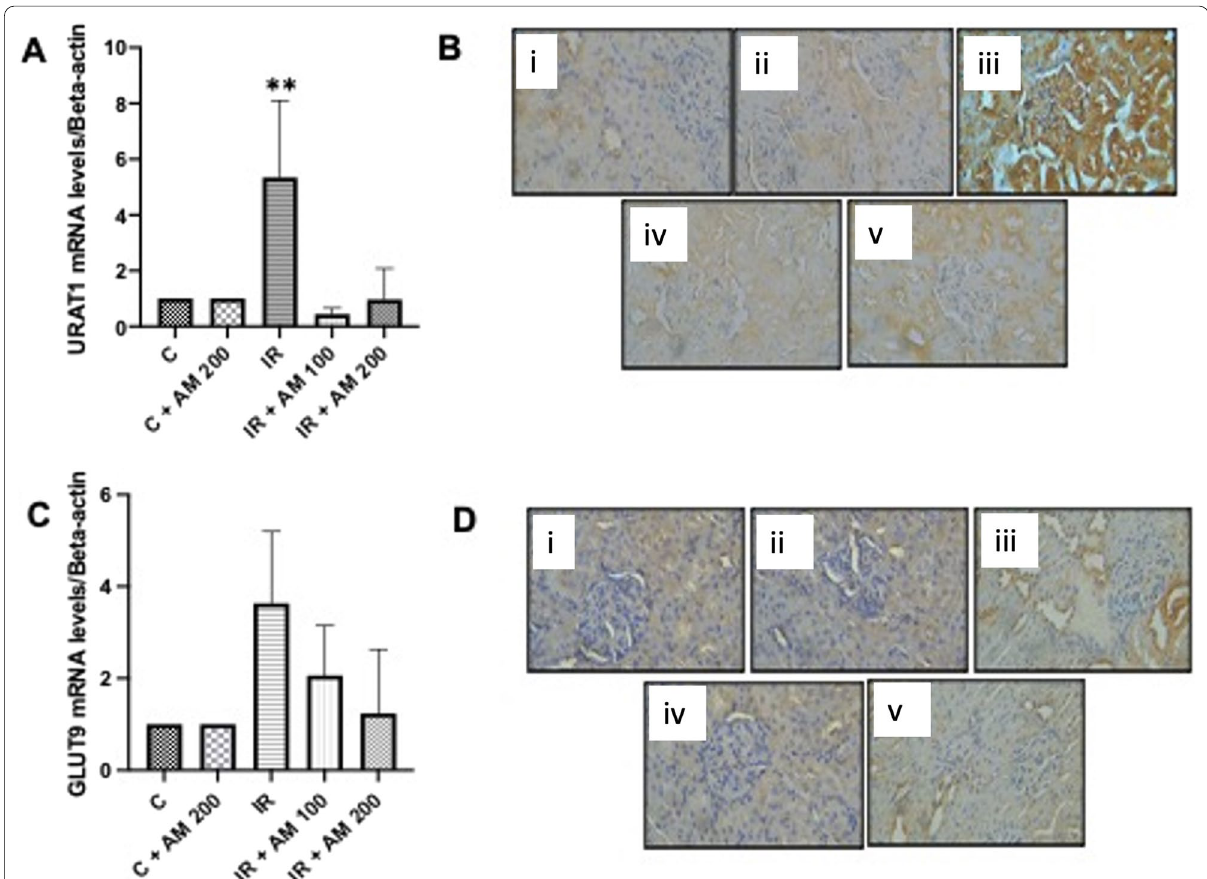
Fig. 3 Effect of AM on A URAT1 mRNA expression, B URAT1 performed by IHC in kidney sections, C GLUT9 mRNA expression, and D GLUT9 performed by IHC. Both expression of URAT1 and GLUT9 mRNA and protein were upregulated in animals fed with HF/HG/STZ injection. ** p < 0.01 versus C and C a-MG 200; †† p < 0.01 versus IR; $$ p < 0.01 versus IR. ( B and D , magnification +